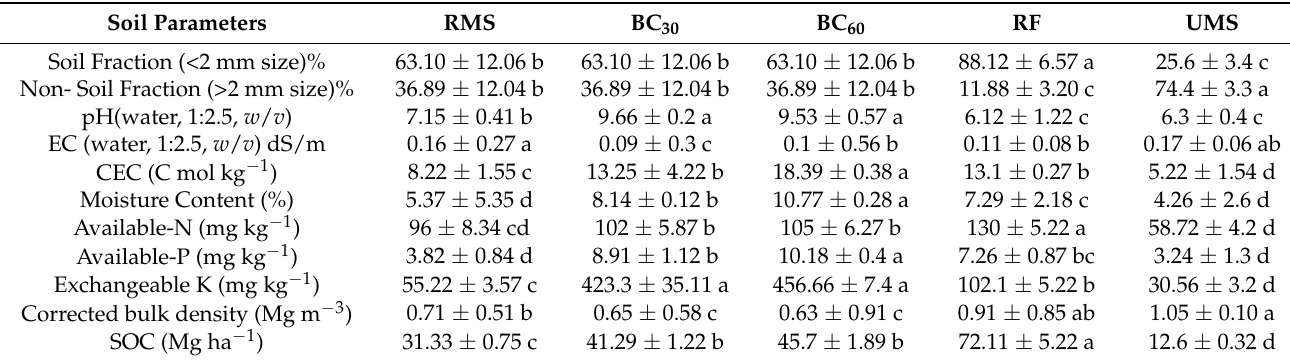
Table 3. Characteristics of RMS (reclaimed mine soil), BC 30 (biochar @ 30 t ha − 1 ), BC 60 (biochar @ 60 t ha − 1 ), RF (reference forest) soil and unreclaimed mine spoil (UMS) ( n = 24, mean ± Standard deviation, within each row, values with same letter are not significantly different, p < 0.05 with Duncan’s multiple range test).